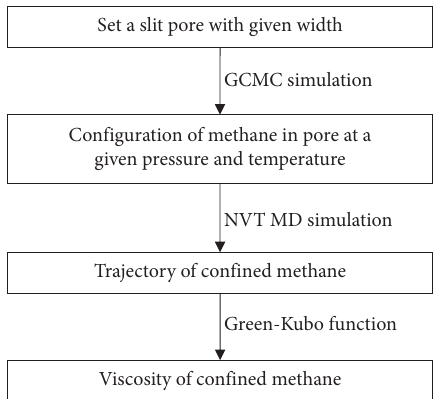
Figure 2: The sketch of workflow to calculate the viscosity of confined methane by molecular simulation.